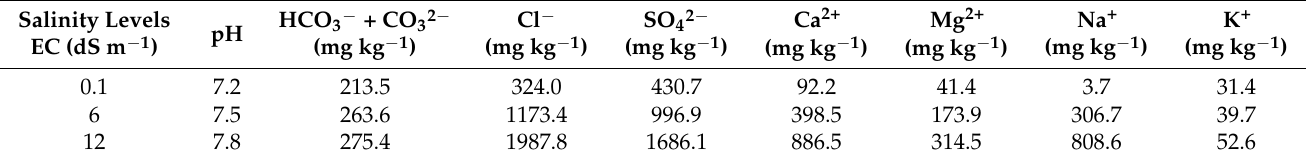
Table 1. Basic characteristics of the soil used in this